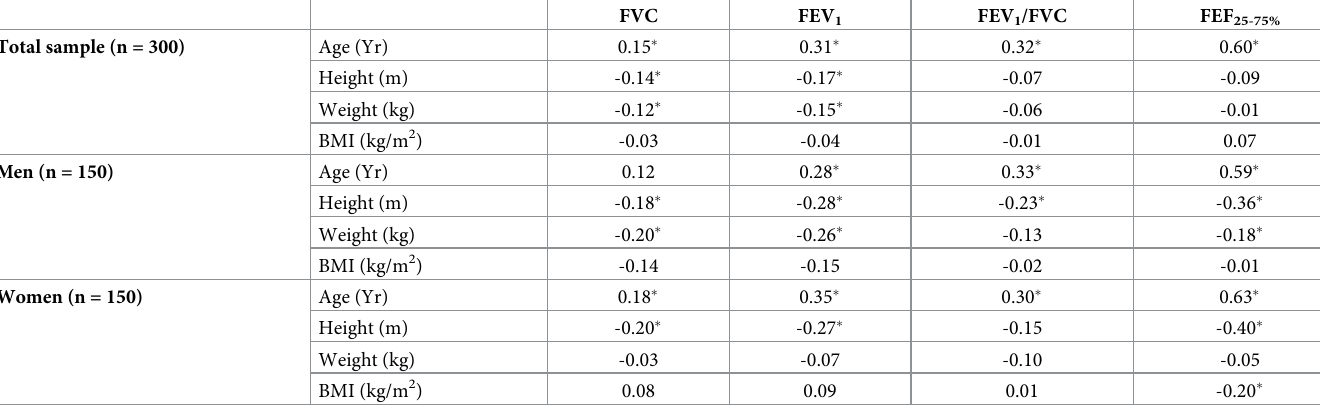
Table 3. Correlation coefficient (r) between the spirometric Z-scores and the anthropometric